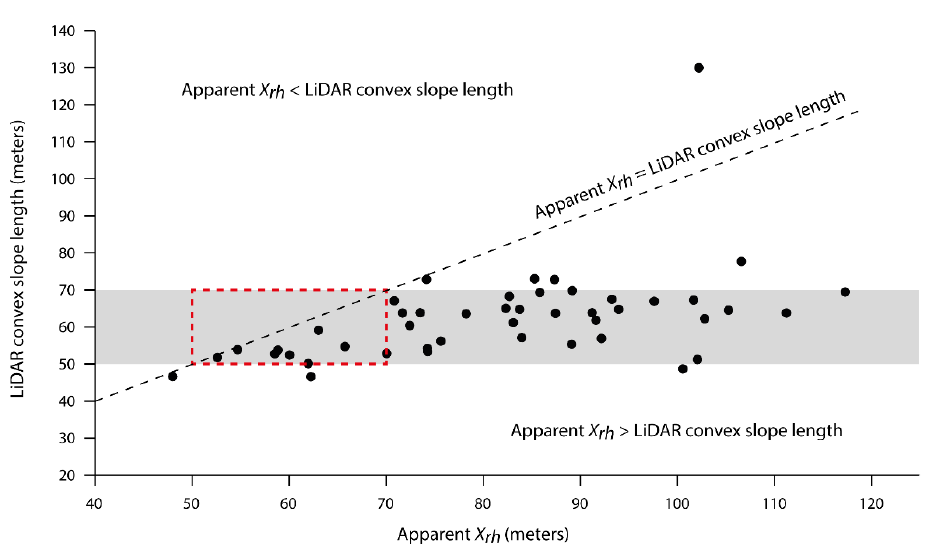
Figure 8. Relationship between the apparent X rh and the LiDAR convex slope length. The agreement between the two measurement methods appears represented as a dotted line. Eighty-three percent of the channels appear plotted in the grey area, representative of LiDAR convex slope length values between 50 and 70 m. Channels with apparent X rh values within a similar range than their LiDAR convex slope length values (50 to 70 m) would be expected to appear plotted inside the red polygon.